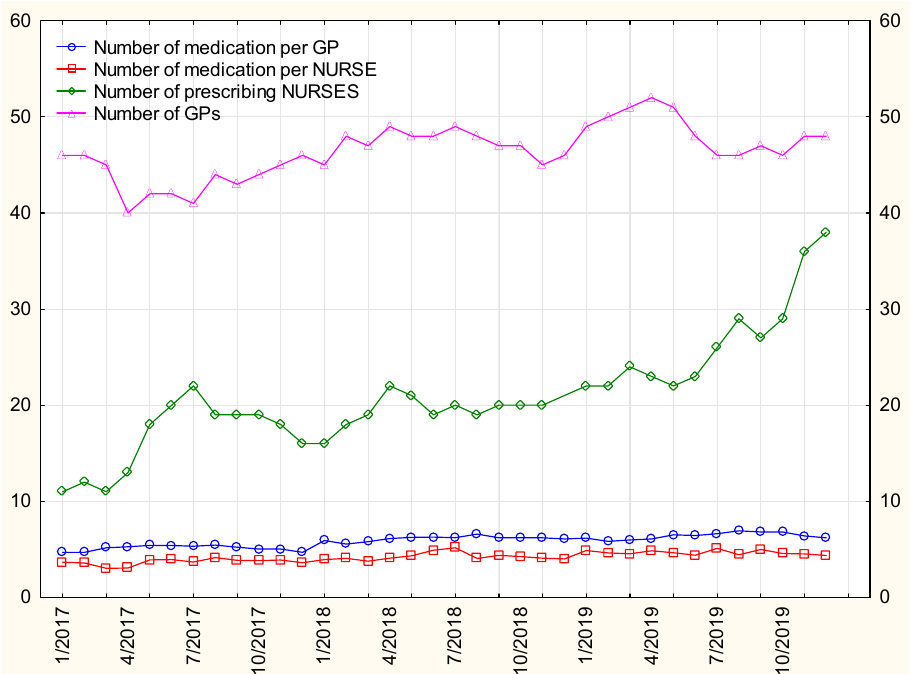
Figure 9. The mean number of medications prescribed by the nurse and GP per patient in relation to the number of prescribing nurses and GPs.